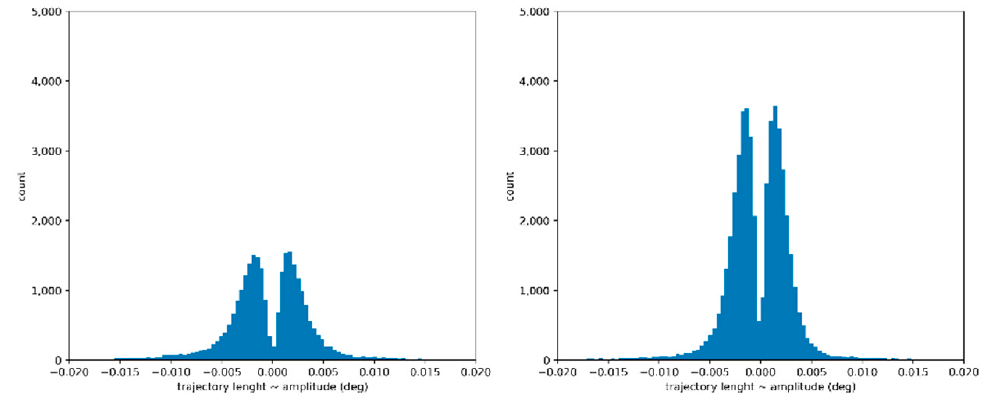
Figure A18. Histogram of the amplitude segments for the painting 7 dataset.